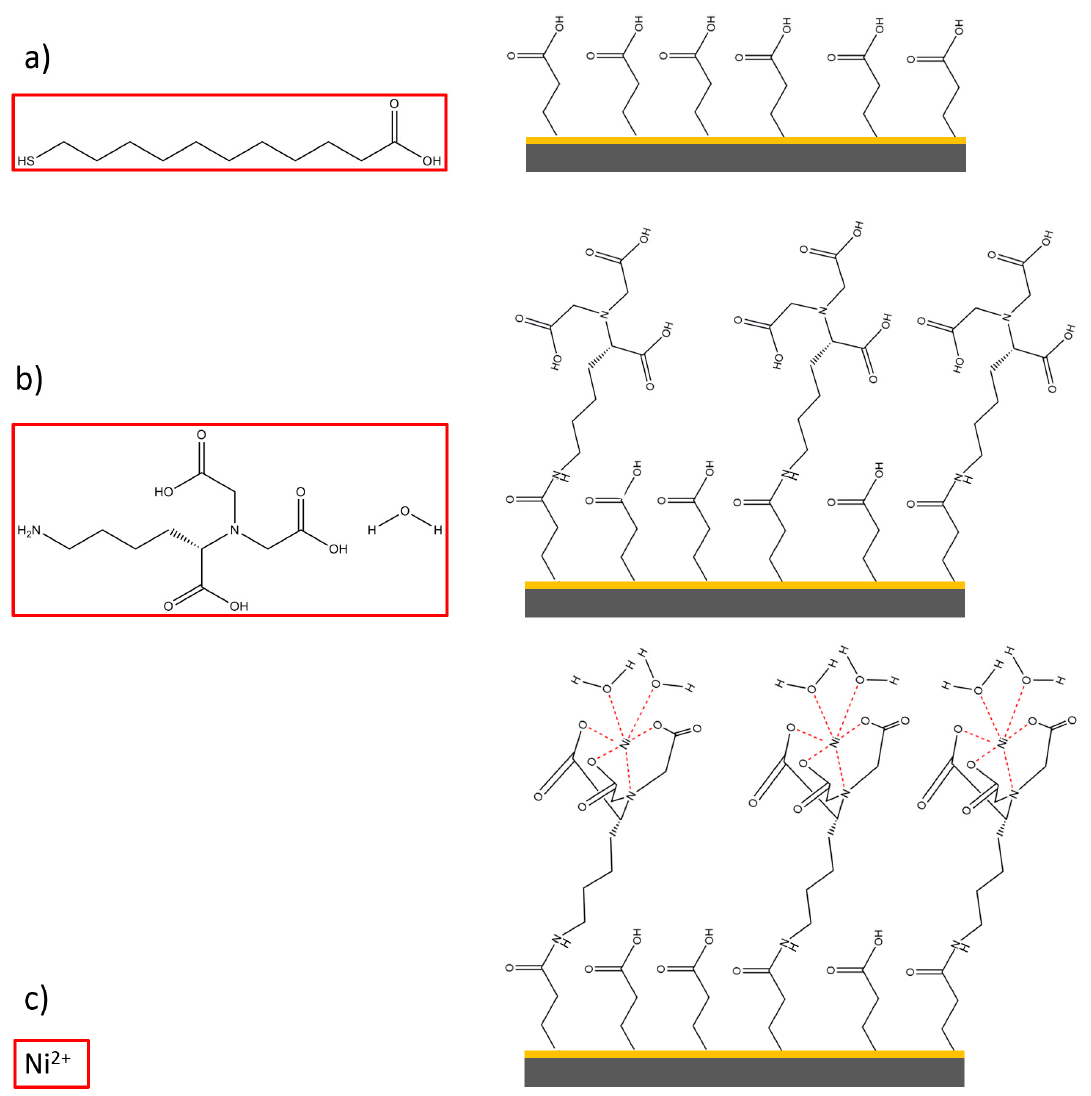
Figure 1. Chemical modification of the gold-coated silicon surface: ( a ) derivatization with MUA, ( b ) NTA-lysine binding ( c ) formation of the NTA-lysine-Ni 2 +